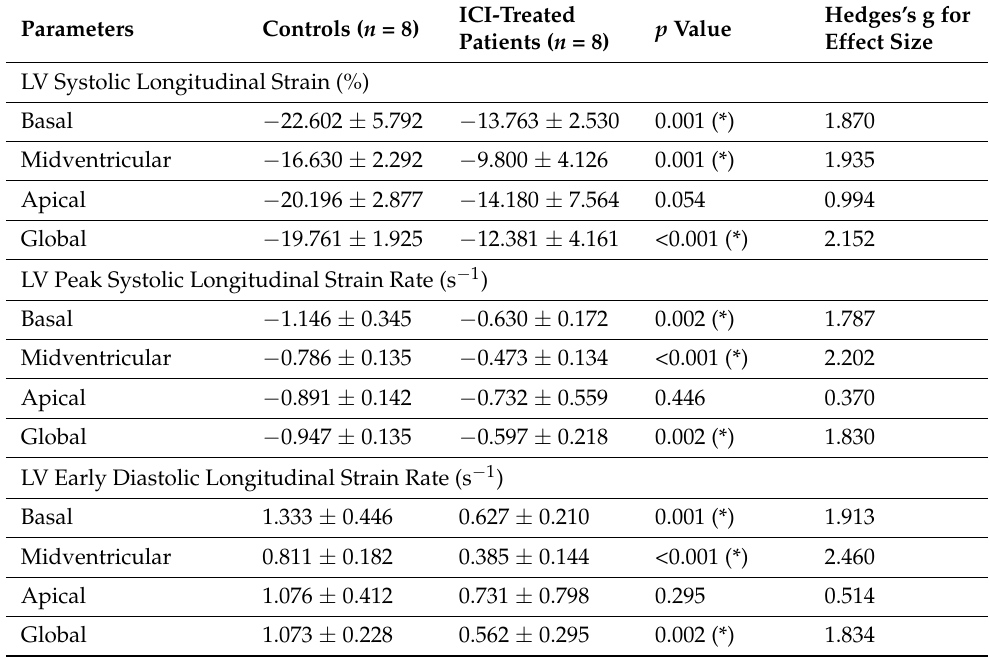
Table 5. Left ventricular (LV) strain and strain rate characteristics of immune checkpoint inhibitor (ICI)-treated patients compared to the controls using